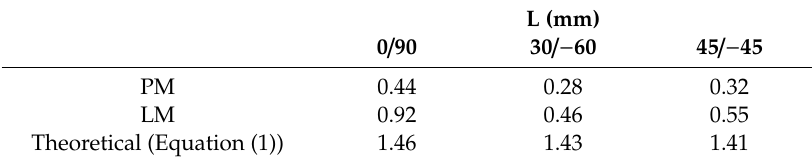
Table 3. Critical distances results for diferent theory of critical distances (TCD)